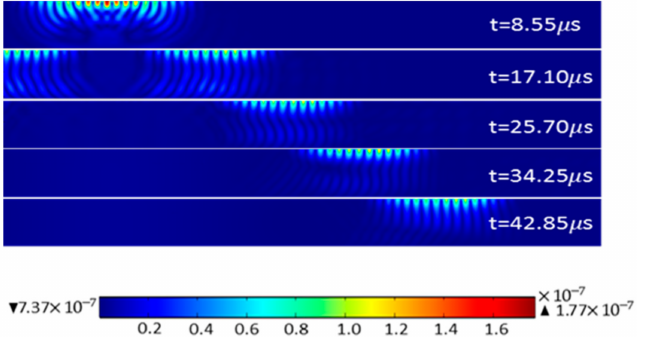
Figure 3. Displacement distribution of surface waves.